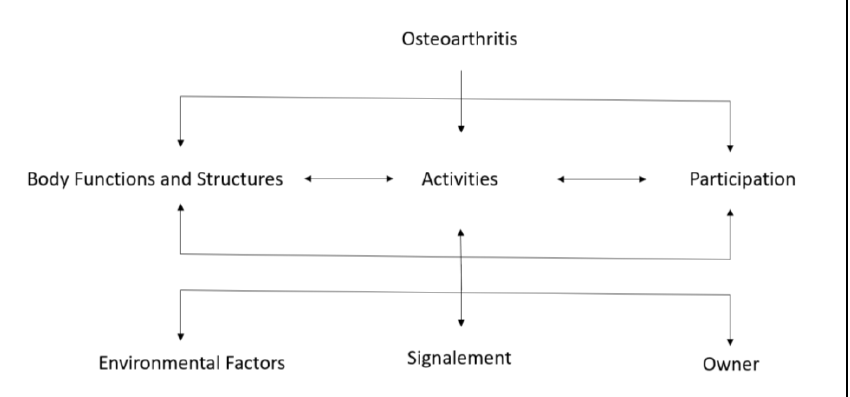
Figure 2. ICF (International Classification of Functioning, Disability and Health) Model modified for OA in veterinary medicine. OA in veterinary